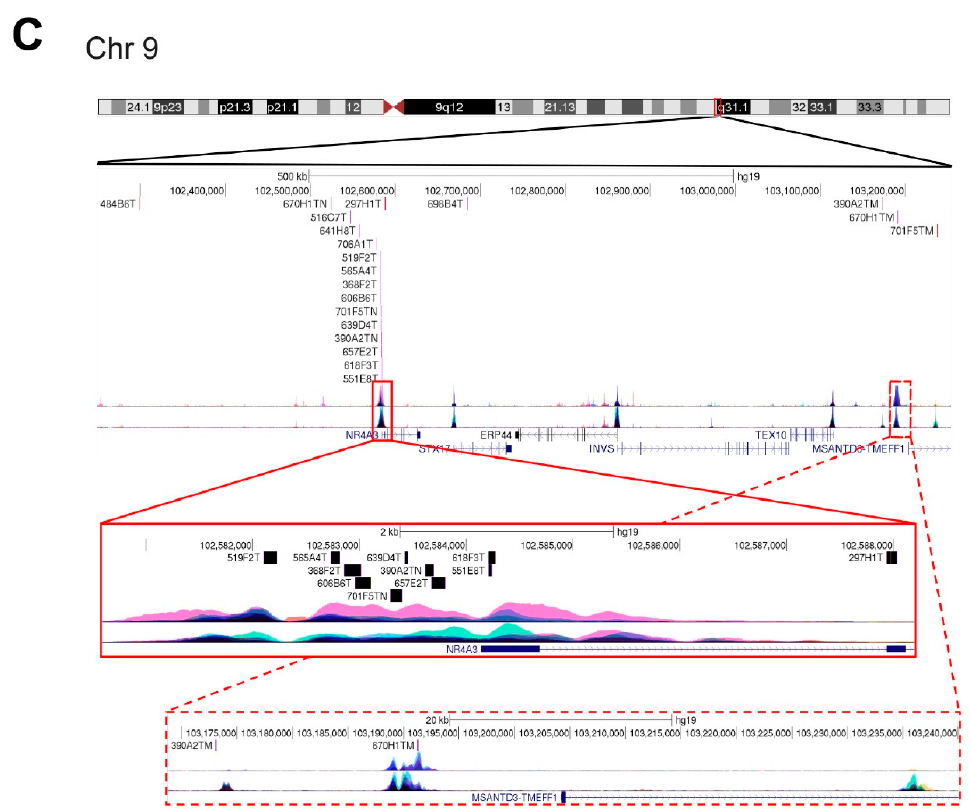
Figure 1. Chromosome fusions in AcCC tumors. ( A ) Diagram summarizes the fusion reads and putative translocations detected by RNA-seq analysis; ( B ) fluorescence in situ hybridization (FISH) analysis to verify the t(4;9) translocation was performed for chromosome 4 (green) and chromosome 9 (red). Yellow signal (arrow) in the tumor is the fusion chromosome; ( C ) chromosome 9 breakpoints. Diagram of the chromosome 9q31.1 region, with locations of translocations identified by RNA-seq fusion reads indicated. Note the clustering of breakpoints in the NR4A3 gene promoter region. Two tumors also had fusion reads that mapped to the MSANTD3 region at right. The insets at bottom show zoomed views of the NR4A3 and MSANTD3 gene regions and the breakpoints near each. Colored peaks indicate H3K27Ac (top) and H3K4Me3 (bottom) peaks from UCSC genome browser tracks (not determined in AcCC cells).